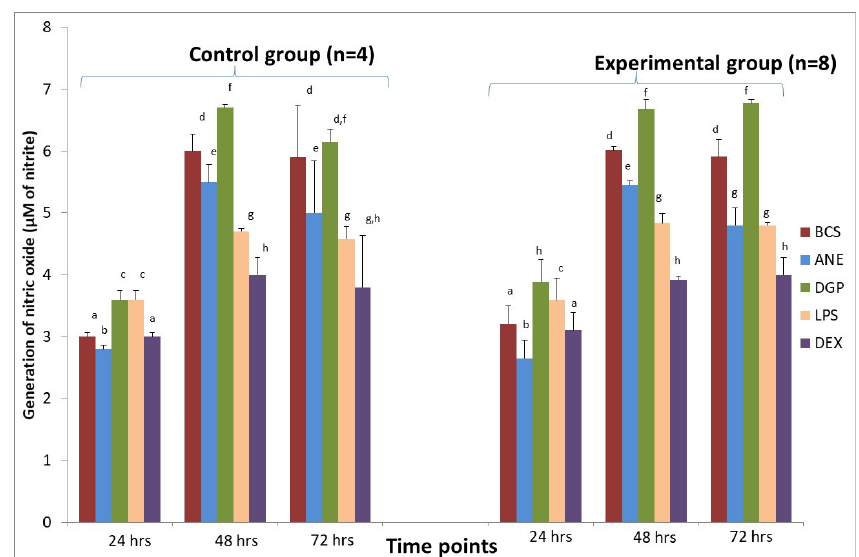
Figure 7. The effect of different stimulators on nitric oxide (NO) generation by macrophages derived from sheep in the control group ( n = 4) and in the experimental group ( n = 8) during insertion of Ti implant into the tibia. BCS—macrophages stimulated only with bovine calf serum, ANE—antimicrobial neutrophil extract, DGP—neutrophil degranulation product, LPS—lipopolysaccharide, DEX—dexamethasone. Values are mean ± SE obtained from each separate experiment conducted in both groups of sheep. There are significant differences between mean values marked with different letters ( p < 0.05). compared to BCS group in each time point.